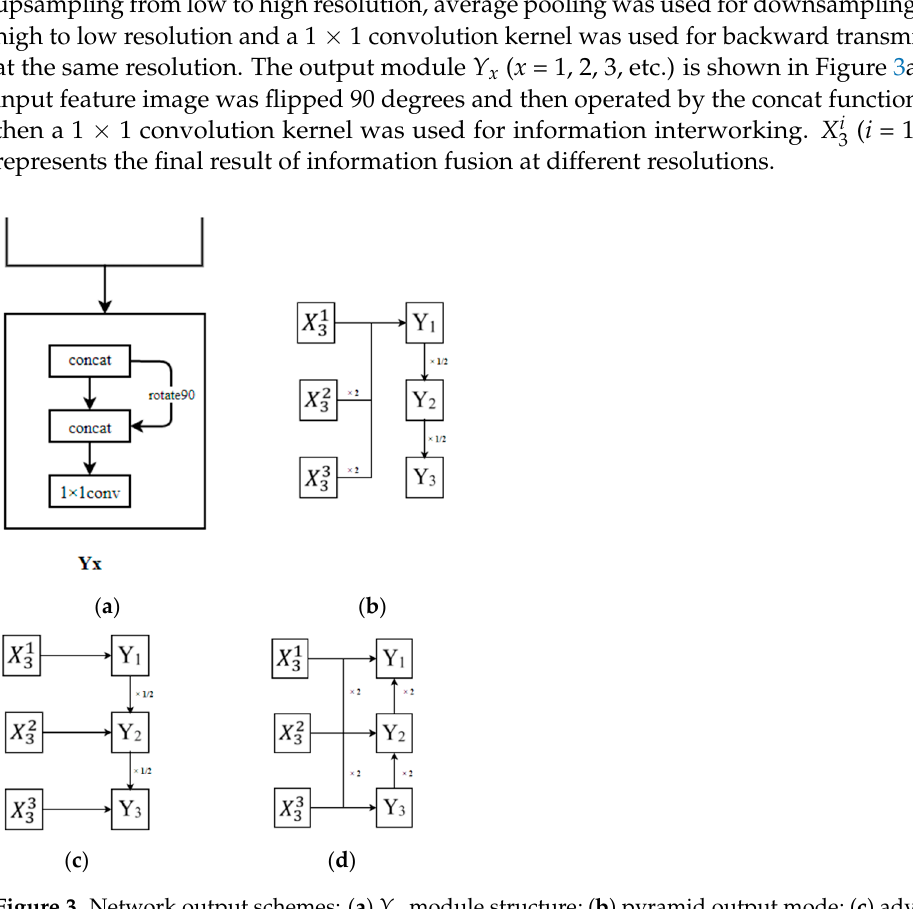
Figure 2. ( a ) Design of the network convolution module N ij ; ( b ) multiscale parallel information ex- change network structure, the IIHNet.